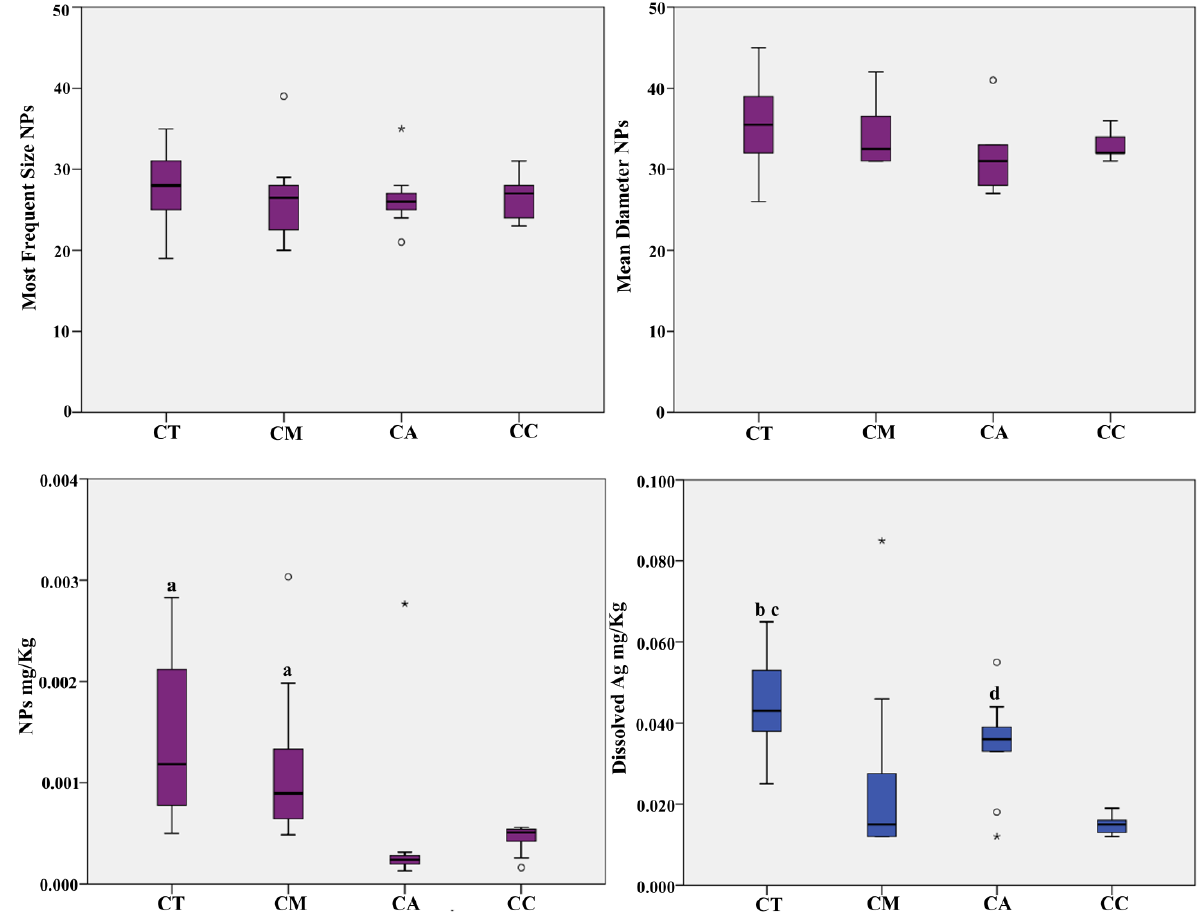
Figure 1. Box Plot distribution of AgNPs most frequent size (nm), mean diameter (nm), level of NPs, and dissolved Ag (mg/Kg) in packaged seafood products. Legend: CT, Canned Tuna; CM, Canned Mackerel; CA, Canned Anchovy; CC, Canned Clam; a, p < 0.05 vs. CA and CC; b, p < 0.01 vs. CM; c, p < 0.001 vs. CC; d, p < 0.05 vs. CC. ◦ Outliers values of the distribution. * Extreme values of the distribution.